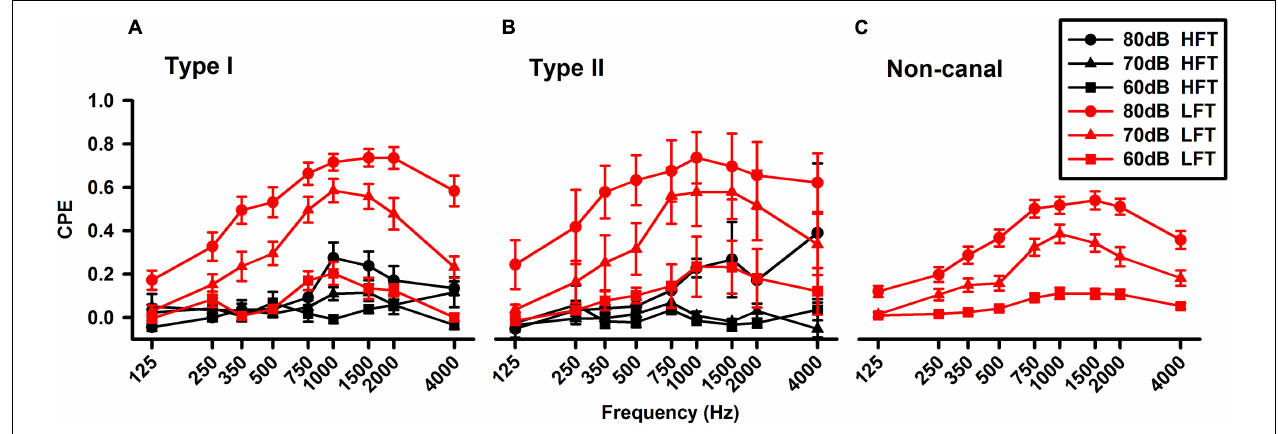
FIGURE 6 | Averaged frequency tuning of the vestibular nucleus neurons. (A) Type I vestibular neurons. (B) Type II vestibular neurons. (C) Non-canal vestibular neurons. The sound sensitive neurons were further classified as LFT (low frequency threshold, red lines) and HFT (high frequency threshold, black lines) neurons. The Type I and II neurons, which included canal-only and canal-otolith convergent neurons, exhibited both HFT and LFT responses, while the non-canal neurons (otolith only) exhibited only LFT